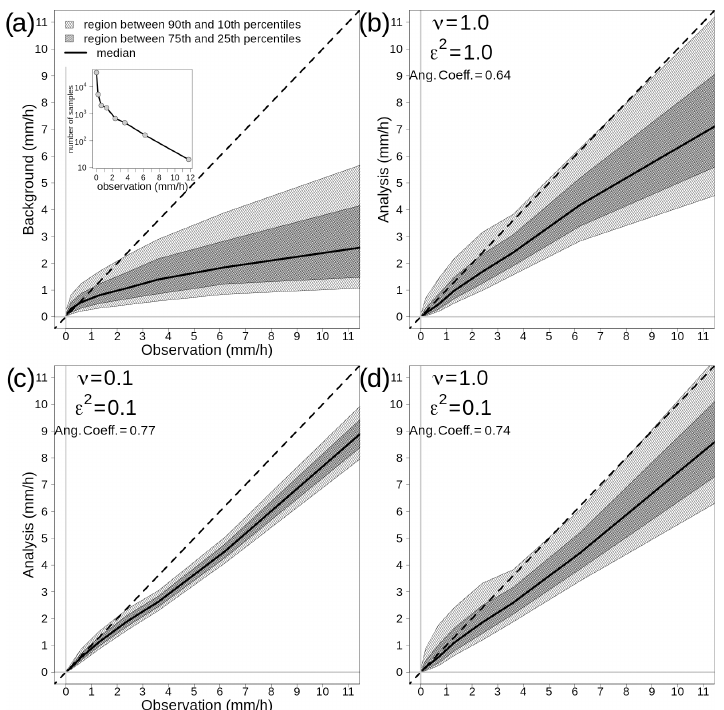
Figure 14. Summer 2019 hourly precipitation statistics for the cross-validation experiments. (a) Background versus observations. (b) Anal- ysis ε 2 = 1 ν = 1 versus observations. (c) Analysis ε 2 = 0 . 1 ν = 0 . 1 versus observations. (d) Analysis ε 2 = 1 . 0 ν = 0 . 1 versus observations. The independent observations have been divided into classes, and the number of samples within each class is shown in the inset of (a) . Within each class and for each probabilistic prediction, several percentiles have been computed. The regions between the average of the 90th and the 10th percentiles are shown with the light gray shading. The regions between the average of the 75th and the 25th percentiles are shown by the dark gray shading. The thick black line indicates the average of the medians. The dashed black line is the diagonal (1 : 1) line. The angular coefficients of the best-fitting lines passing through the origins and better approximations of the averages of the medians are shown; for the background in (a) , it is 0.26 (not shown in the